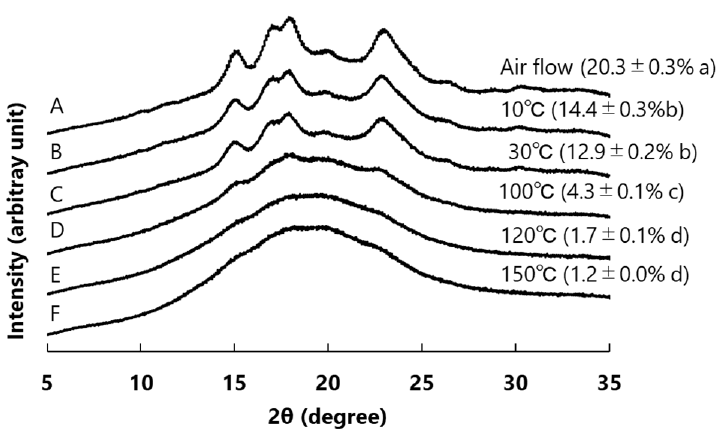
Figure 1. Wide-angle X-ray diffraction (WAXD) patterns and degree of crystallinity (%) of rice flour samples prepared by the SHMM treatment at different temperatures or by air flow milling. ( A ) Rice flour samples prepared by air flow milling. ( B – F ) Rice flour samples subjected to SHMM at 10 ◦ C ( B ), 30 ◦ C ( C ), 100 ◦ C ( D ), 120 ◦ C ( E ), and 150 ◦ C ( F ). Percentages indicate the degree of crystallinity. Data represent mean ± standard error (SE; n = 3). Different lowercase letters (a–d) in the figure indicate significant differences, as determined by the Tukey–Kramer method ( p <